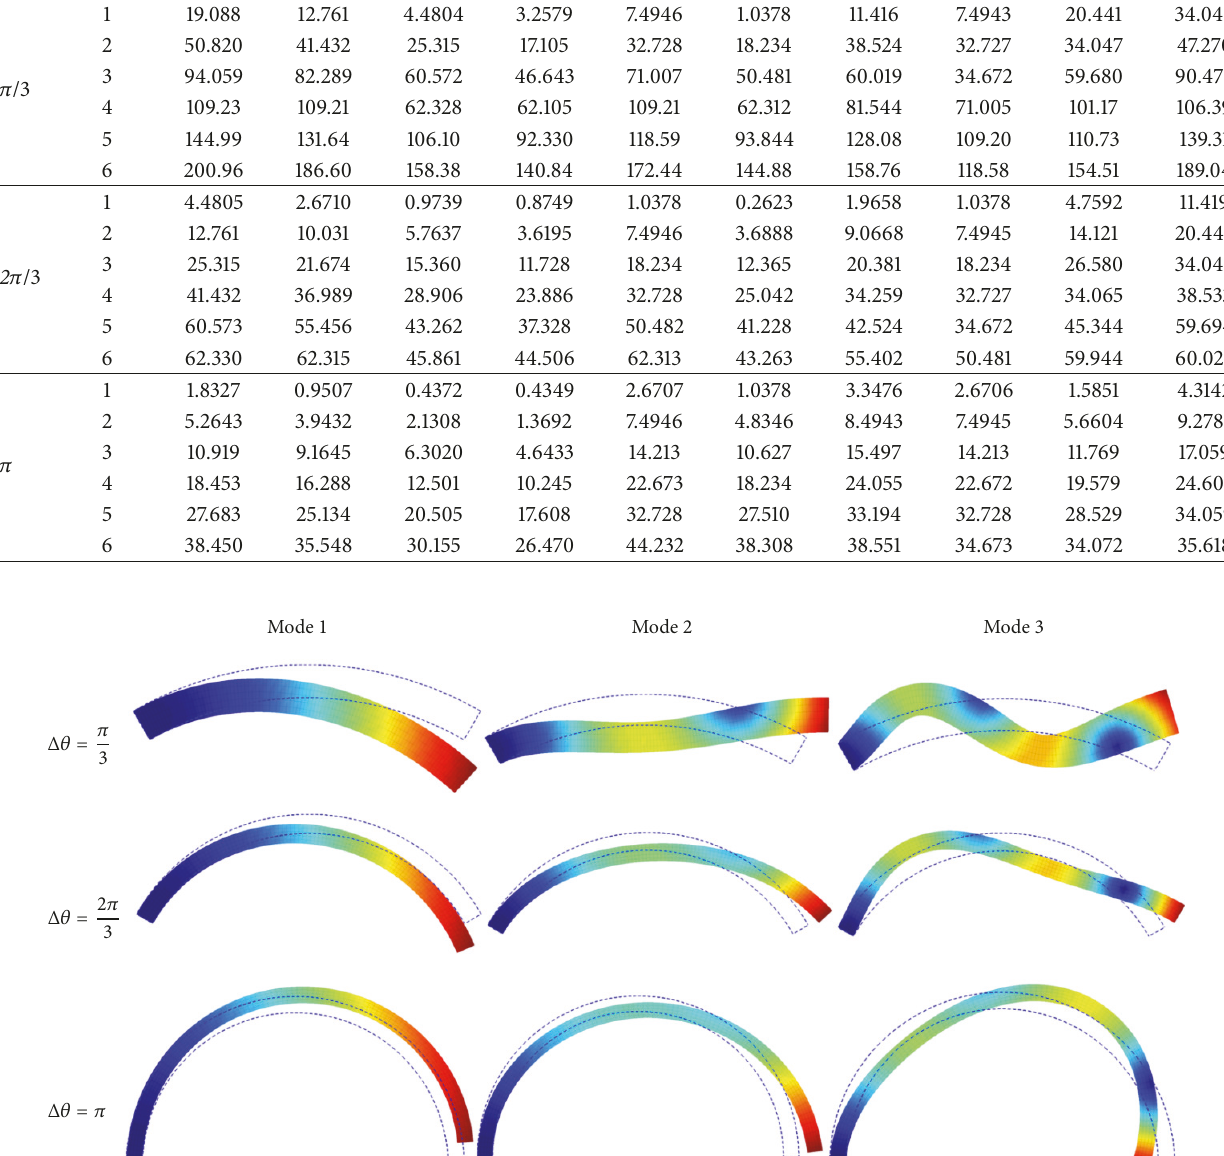
Table 5: The lowest six frequency parameters Ω of classically restrained circular beams with various span angles ( 𝑅 𝑚 = 1 m, ℎ/𝑅 𝑚 = 0.1 ). Δ𝜃 Mode